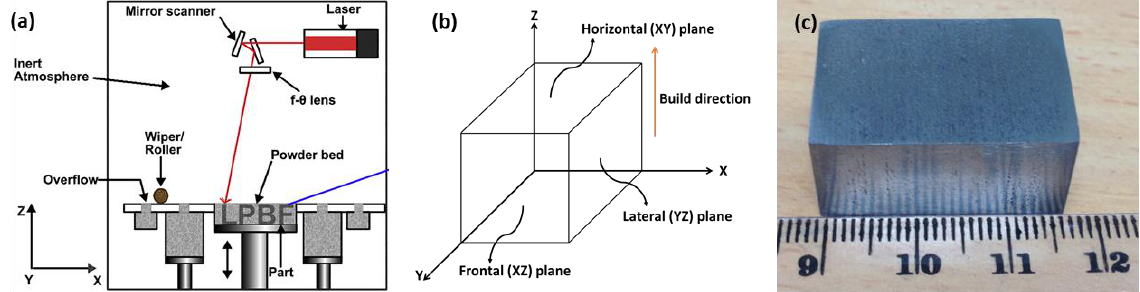
Figure 1. Schematic of ( a ) L-PBF process [25] and ( b ) sample orientation and associated investigated planes, together with ( c ) optical photographs of the L-PBF-processed sample.